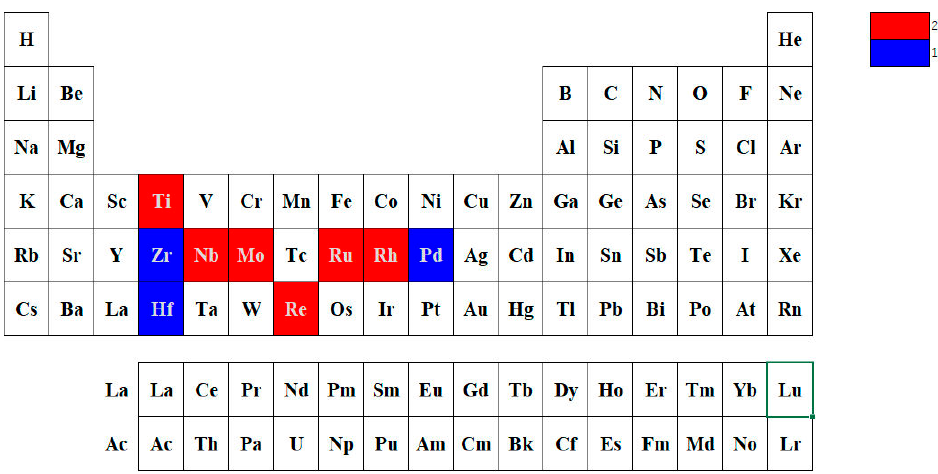
Figure 6. Frequency with which elements are used in hcp and hcp-related HEA superconductors reported to date (Nos. 1–3 in Table 3). The frequencies are 2 for Ti, 1 for Zr, 2 for Nb, 2 for Mo, 2 for Ru, 2 for Rh, 1 for Pd, 1 for Hf, and 2 for Re.